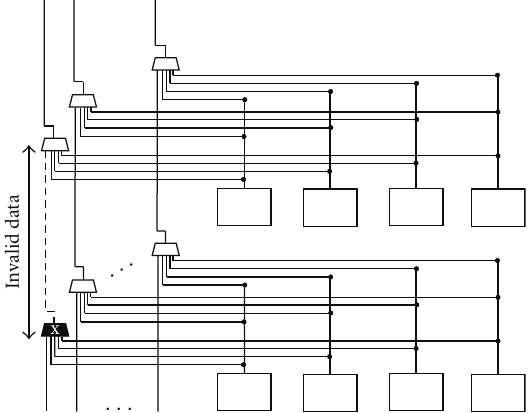
Figure 8: Defective input multiplexer tolerance approach—the defective input multiplexer invalidates the functional unit.